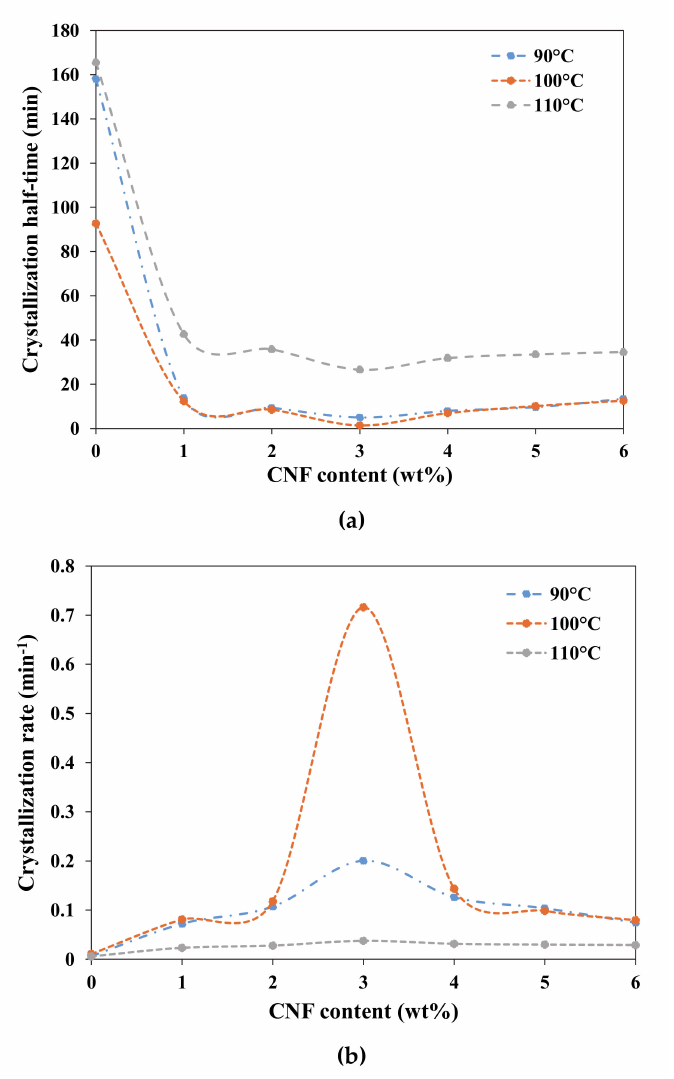
Figure 5. Dependence of ( a ) crystallization half-time and ( b ) crystallization rate on CNF content for PLA melt-crystallized isothermally at 90, 100, and 110 ◦